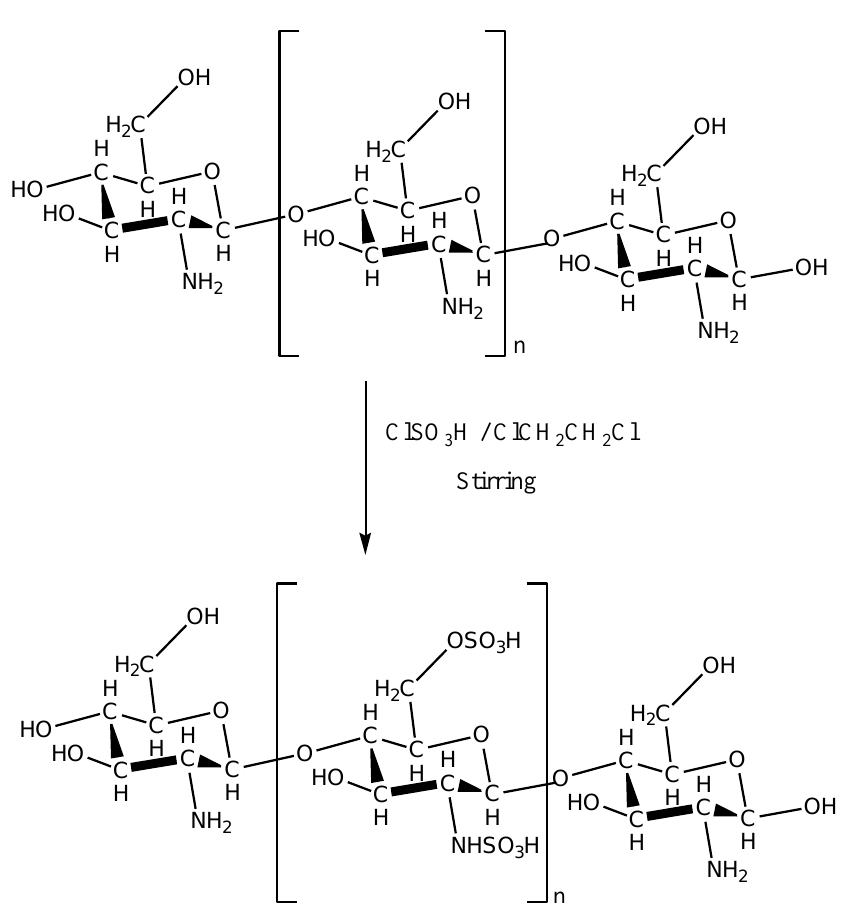
Figure 1. Scheme of the preparation of chitosan with sulfonic acid groups (R = –H or –COCH 3 ). Table 1. Characterization of chitosan and chitosan with sulfonic acid groups.